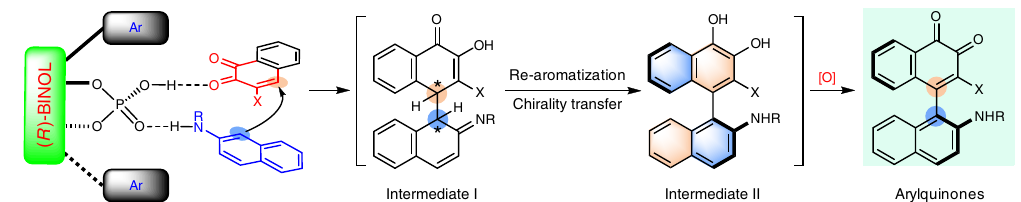
Fig. 3 Proposed reaction pathway. The reaction sequence follows chiral phosphoric acid catalyzed asymmetric conjugate addition, re-aromatization with central-to-axial chirality conversion